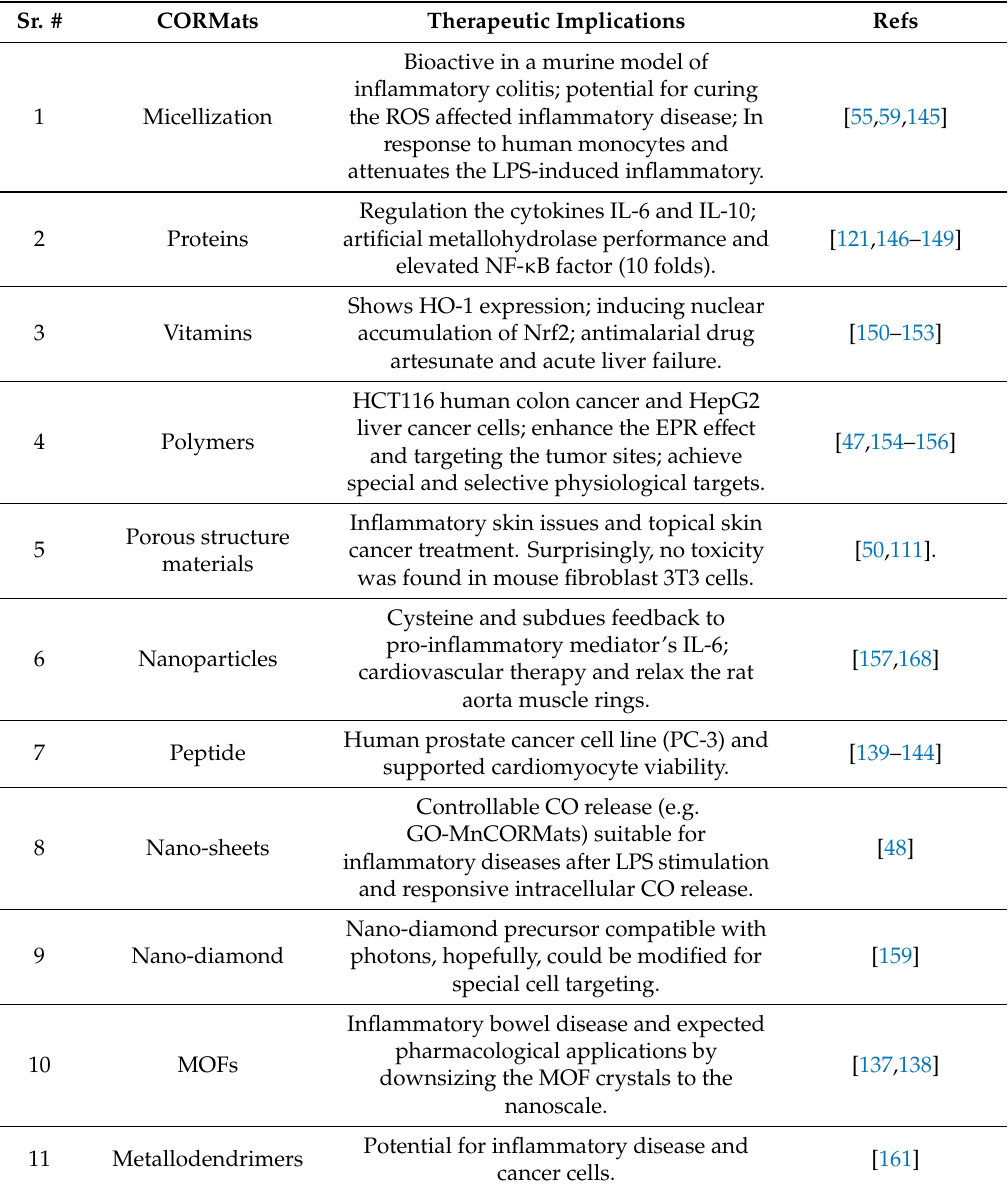
Table 2. Conjugate strategies for therapeutic CO